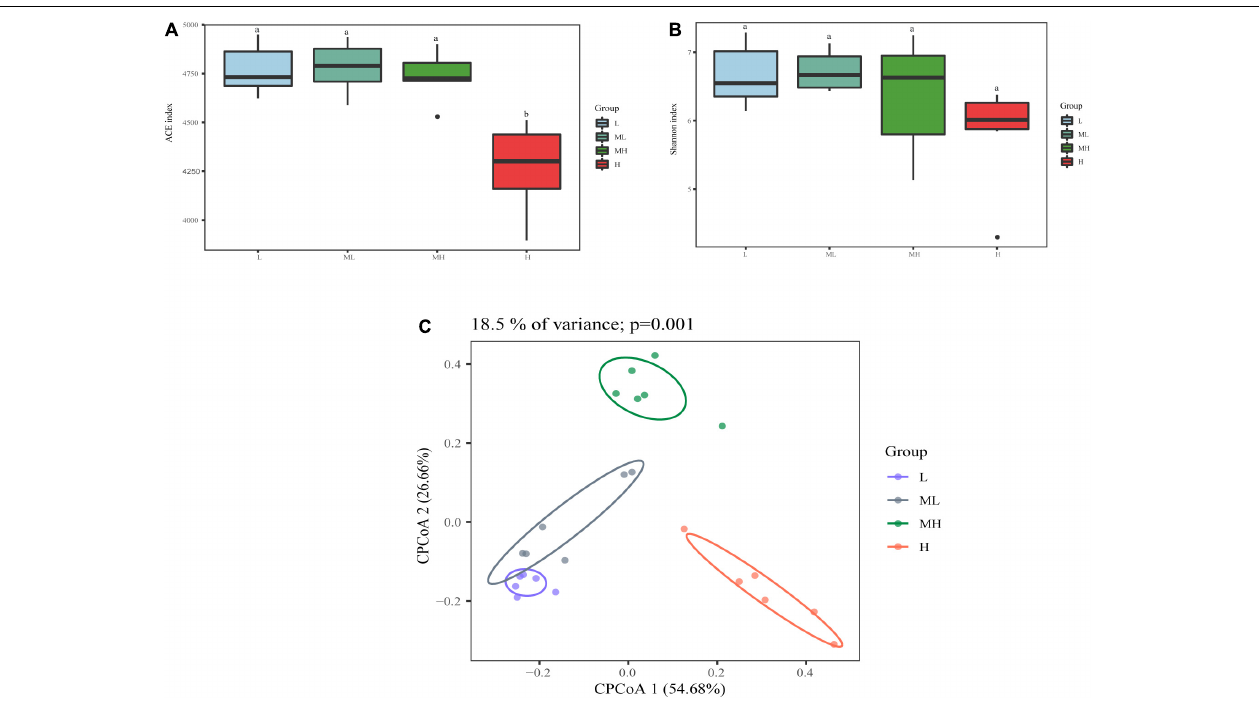
FIGURE 1 | Bacterial diversity analysis of rumen samples between yak fed diets with different protein levels. The alpha diversity between different groups (A) ACE index; (B) Shannon diversity; beta diversity (C) CPCoA plot using Bray–Curtis dissimilarity based on ASVs in different groups.